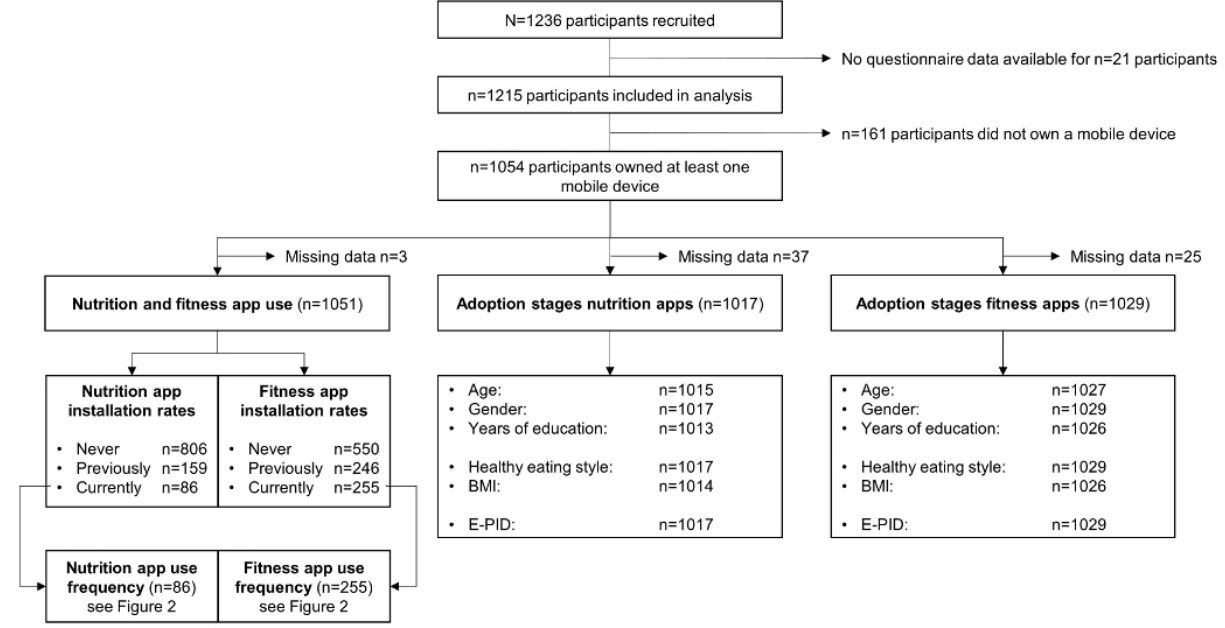
Figure 1. Flowchart of the study